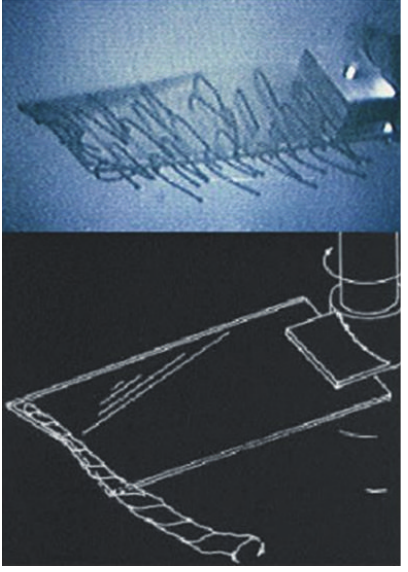
Figure 5: HE-3 impeller vortex.